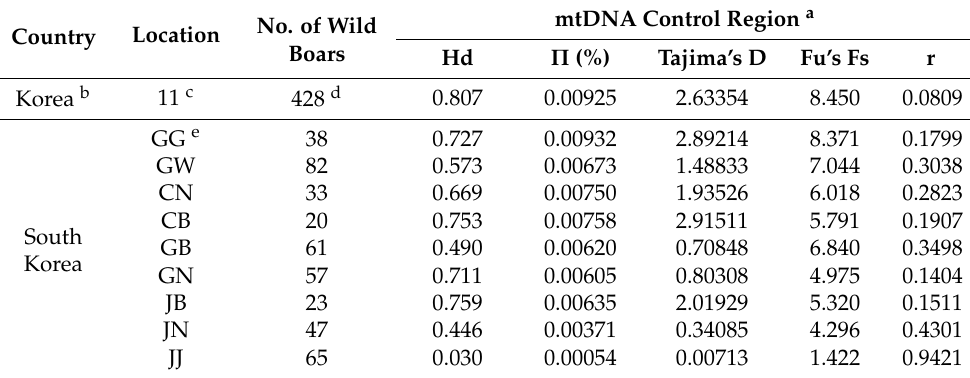
Table 3. Genetic variability and demographic analysis of mitochondrial DNA from wild boars captured in different geographical regions of North and South Korea.